Question: Based on the figure, does the quantity rise or fall?
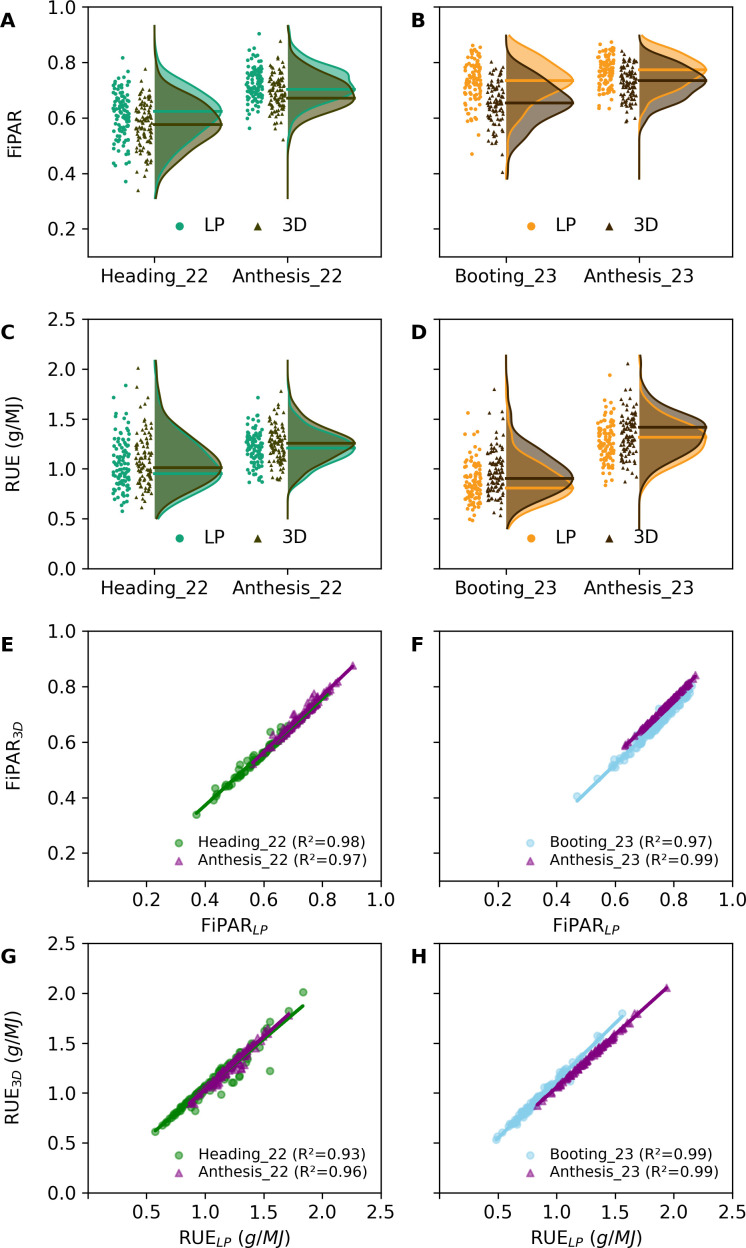
Answer: increasing